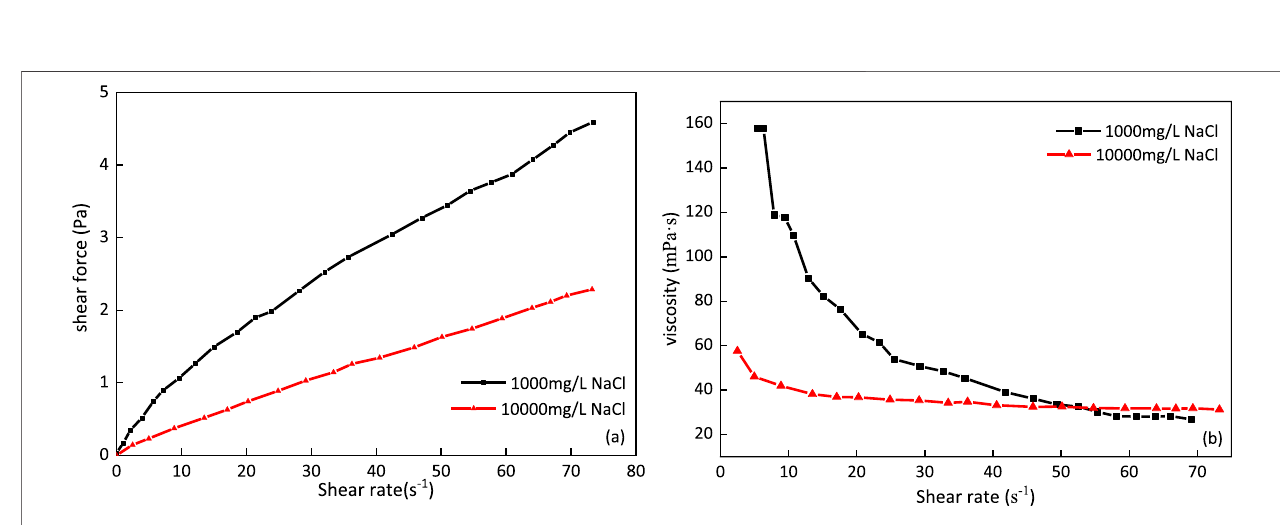
FIGURE 13 | Rheology of the m -HPAE solution in 1,000 mg/L and 10,000 mg/L salt solution.